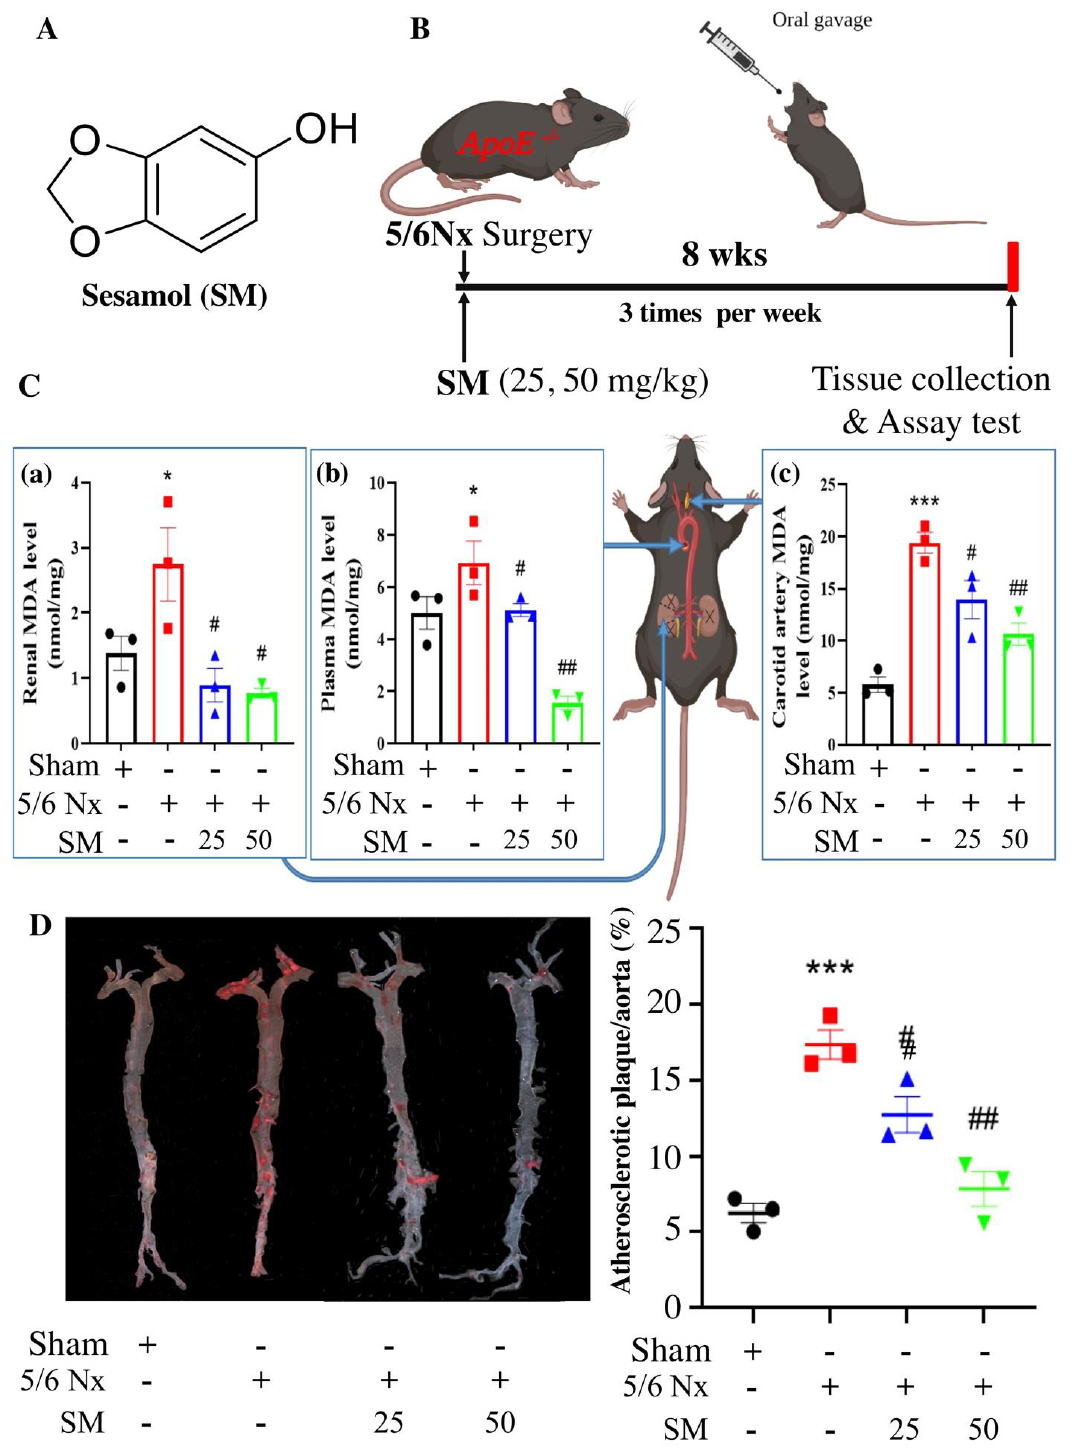
Figure 1. Sesamol (SM) reduces reactive oxygen species (ROS) levels and atherosclerosis in 5/6 Nx ApoE –/– mice. ( A ) Struc- ture of SM. ( B ) Schematic representation of the experimental mouse model. ( C ) Lipid peroxidation was assessed by measuring malondialdehyde (MDA) level. MDA level in (a) the kidney, (b) plasma, and (c) carotid artery in ApoE –/– mice. ( D ) Representative aortas from mice in each group stained with Oil Red O and quantification of aortic root lesion sizes. Data are presented as mean ± SEM ( n = 3 per group). * p < 0.05, *** p < 0.001 vs. sham group; # p < 0.05, ## p < 0.01 vs. 5/6 Nx group in ApoE –/–